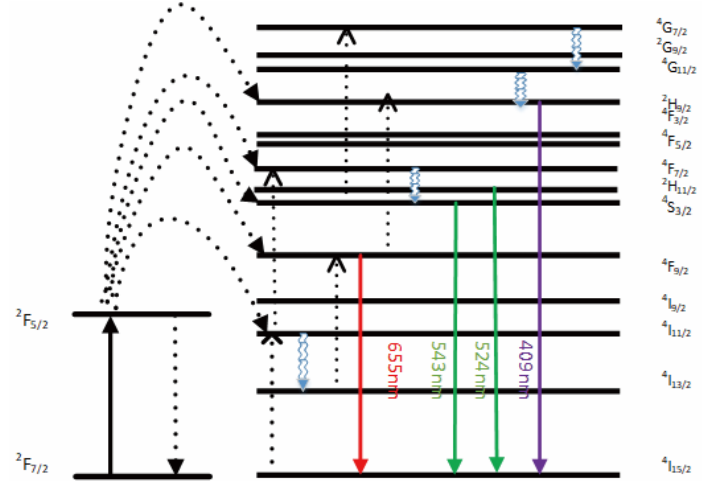
Figure 3. A simplified energy level diagram of Er 3+ /Yb 3+ system doped with Au and up-conversion pathways.